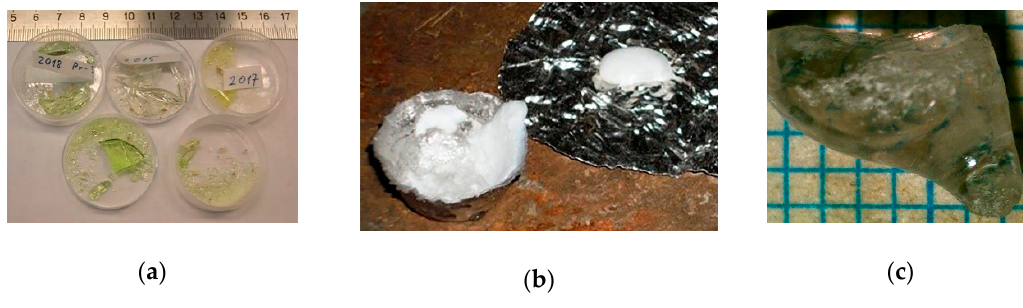
Figure 12. As-obtained ceramics: ( a ) transparent YAB-based glass–ceramic composites; ( b ) GdAB-containing glaze; ( c ) transparent GdAB-based glass–ceramic composites [56]. Figures 12a and 12b